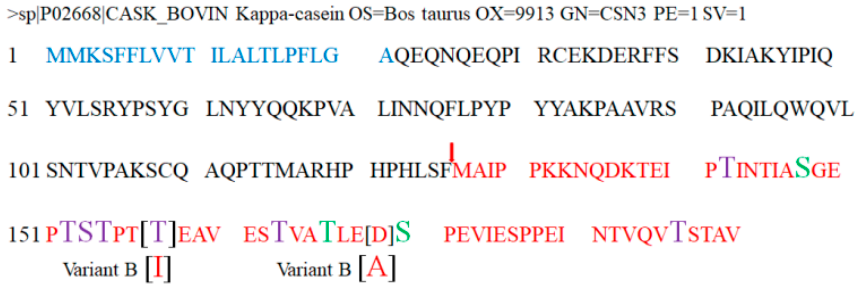
Figure 1. Amino-acid sequence of Bos taurus κ -casein protein. The sequence is reported in database UniProtKB accession number P02668. The blue-colored sequence corresponds to a signal peptide and red sequence corresponds to glycomacropeptide (GMP). Chymosine’s cleave site is indicated with red arrow. Purple amino acids indicate glycosylation sites, and green amino acids show phosphorylation sites. The modification in variant B of GMP is indicated in square brackets.